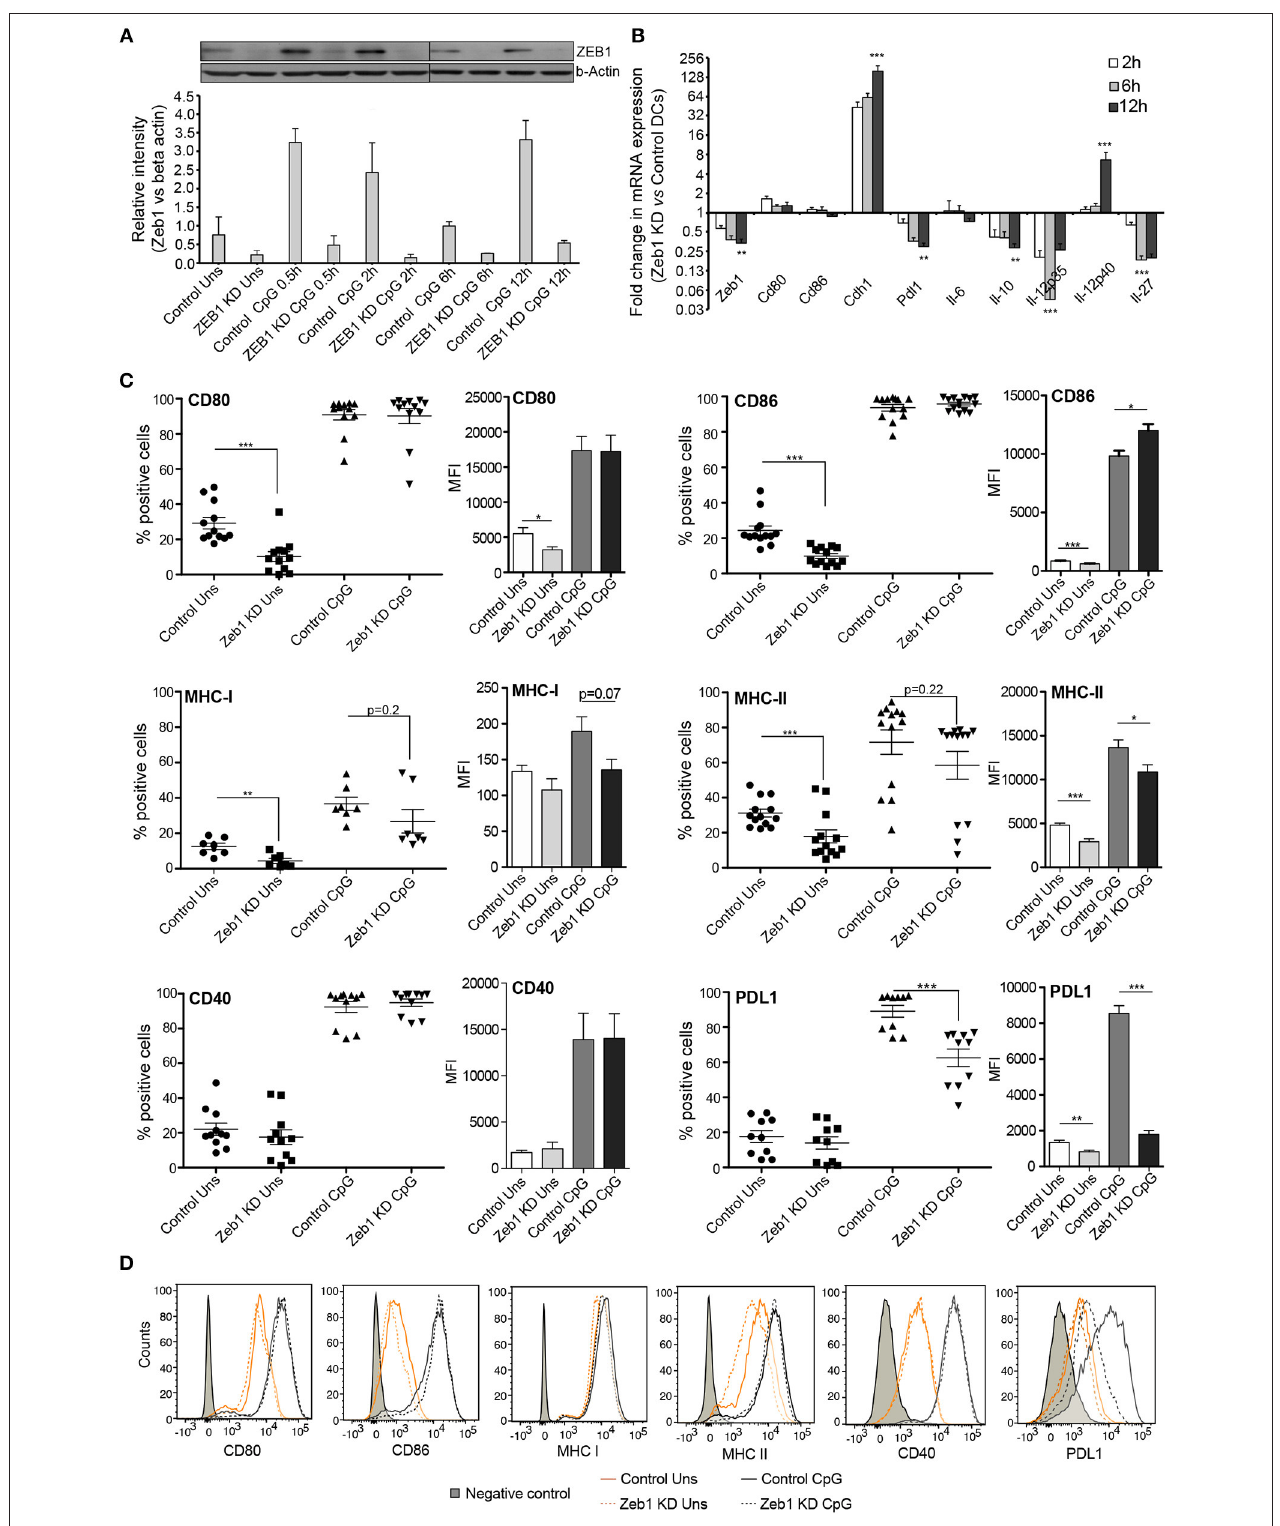
FIGURE 1 | Zeb1 transcription factor KD suppresses activation and co-stimulation of CD8 α + cDC1 MutuDCs. (A) Western blot and its densitometric analysis showing the ZEB1 protein expression kinetics and its KD by shRNA at 0, 0.5, 2, 6, and 12h after CpG activation in CD8 α + cDC1 DCs n = 2. (B) Bar-plot demonstrating the fold changes in the transcript expression of DC activation/co-stimulation markers and selected cytokine genes in Zeb1 KD DCs compared to control cells using